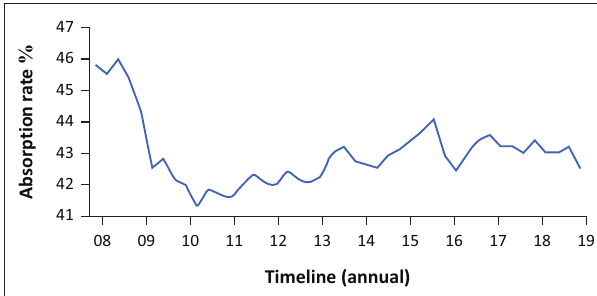
FIGURE 1: Labour absorption rate of